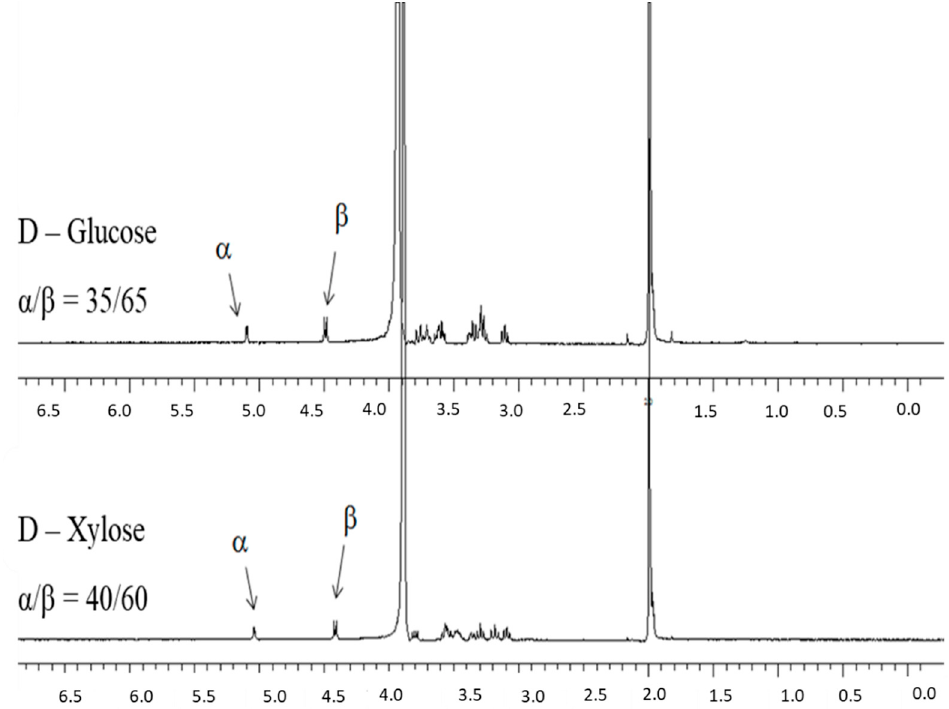
Figure 4. 1 H-NMR spectra (CD 3 CN/D 2 O 85/15% v / v ) of a solution of D-glucose [2 mg/mL] and of a solution of D-xylose [2 mg/mL] both equilibrated at 25 °C for 72 h in order to determine the anomeric ratio α / β .